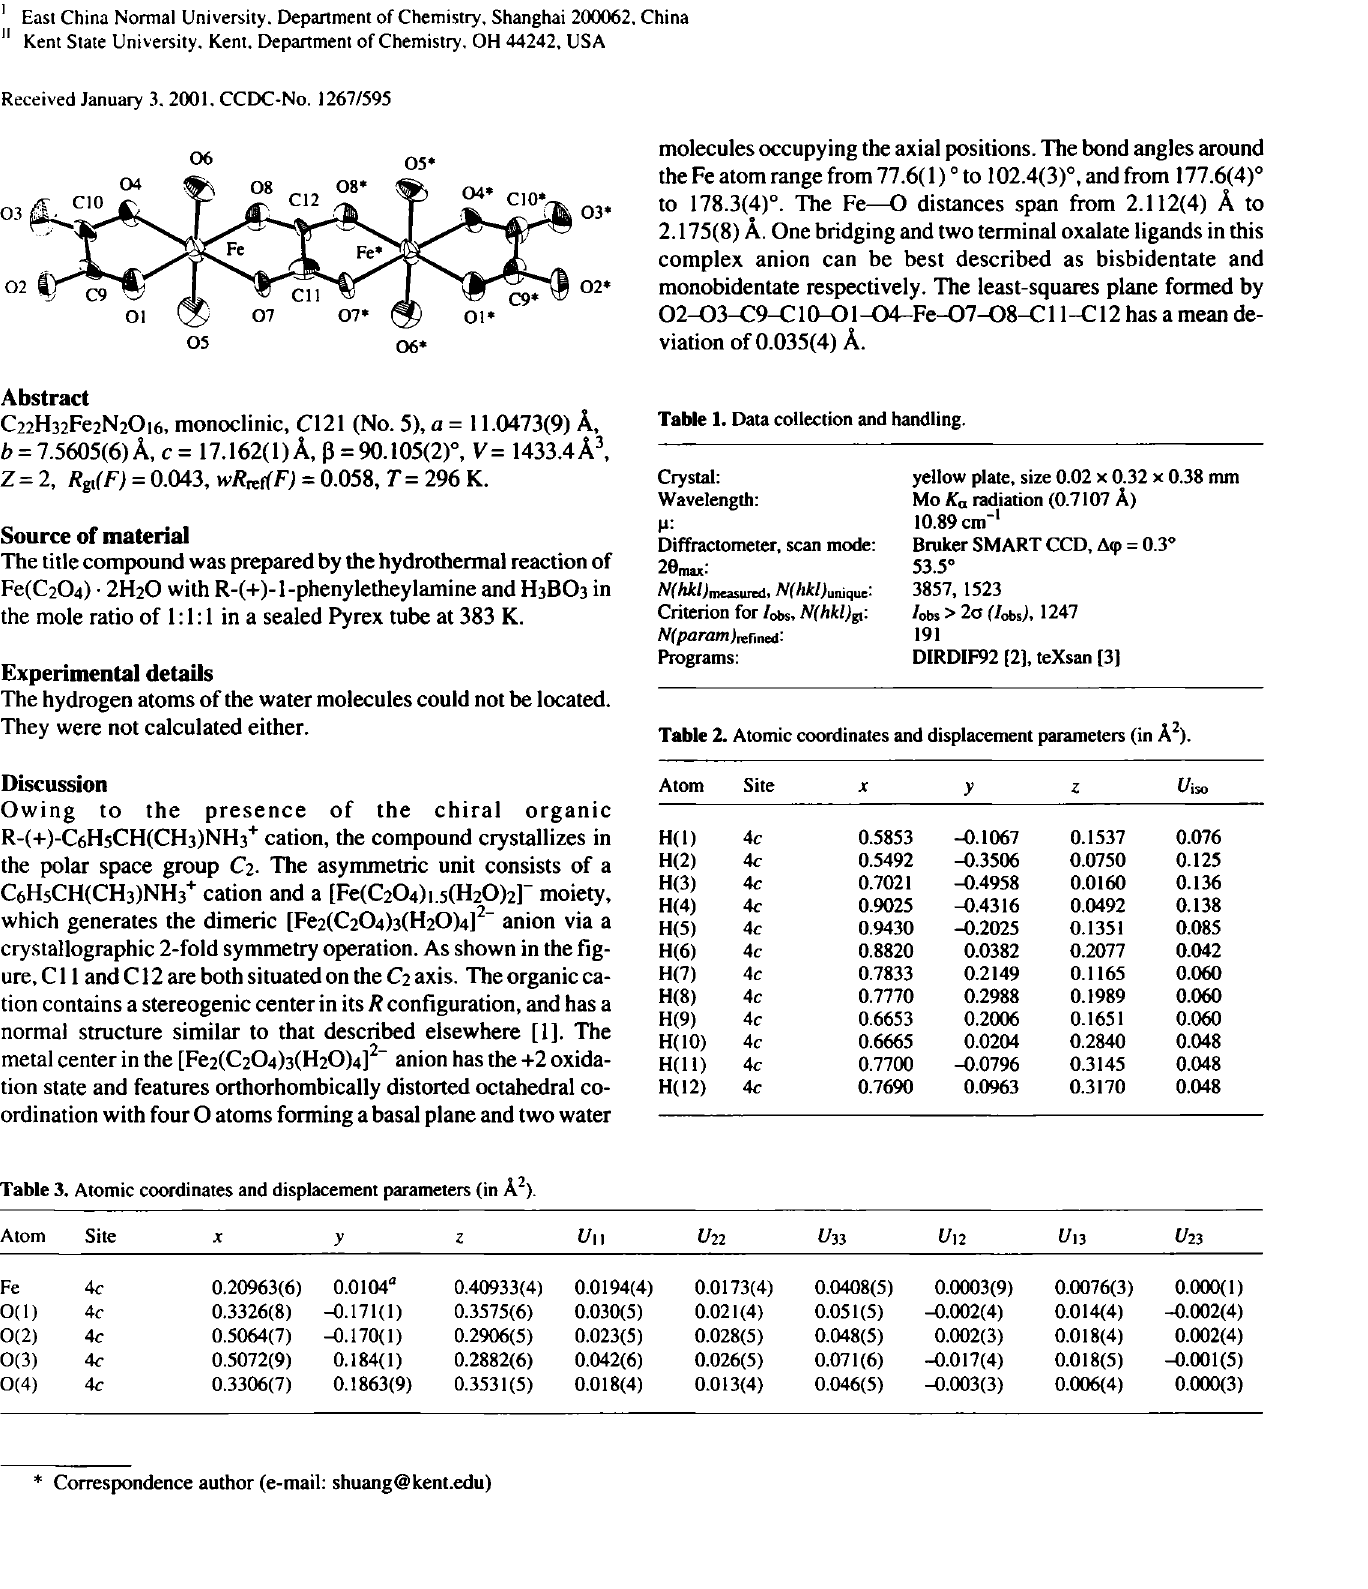
Table 1. Data collection and handling. Crystal: